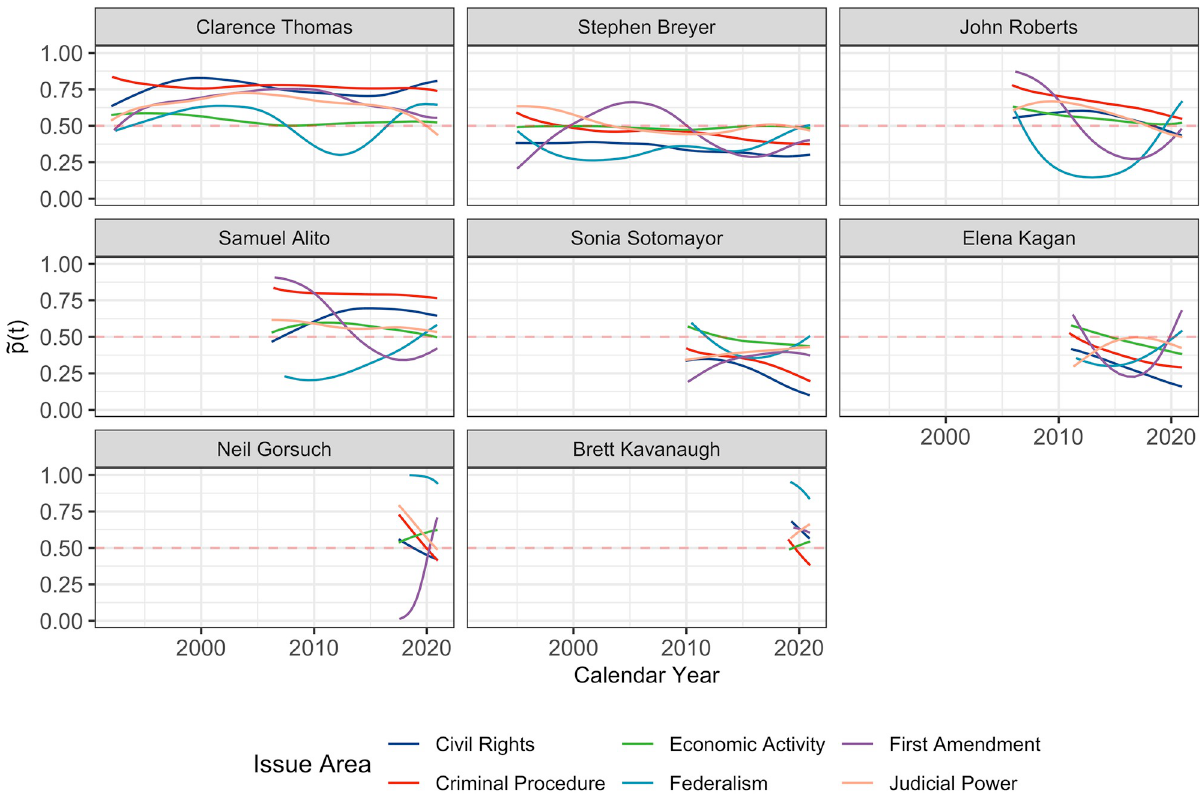
Fig 10. The inferred latent policy position processes ~ p ð t Þ in the probability scale. These processes are obtained per Eqs (7) and (8) for the currently serving justices by issue areas, using only votes concerning selected issue areas: criminal procedure, civil rights, First Amendment, economic activity judicial power and federalism,